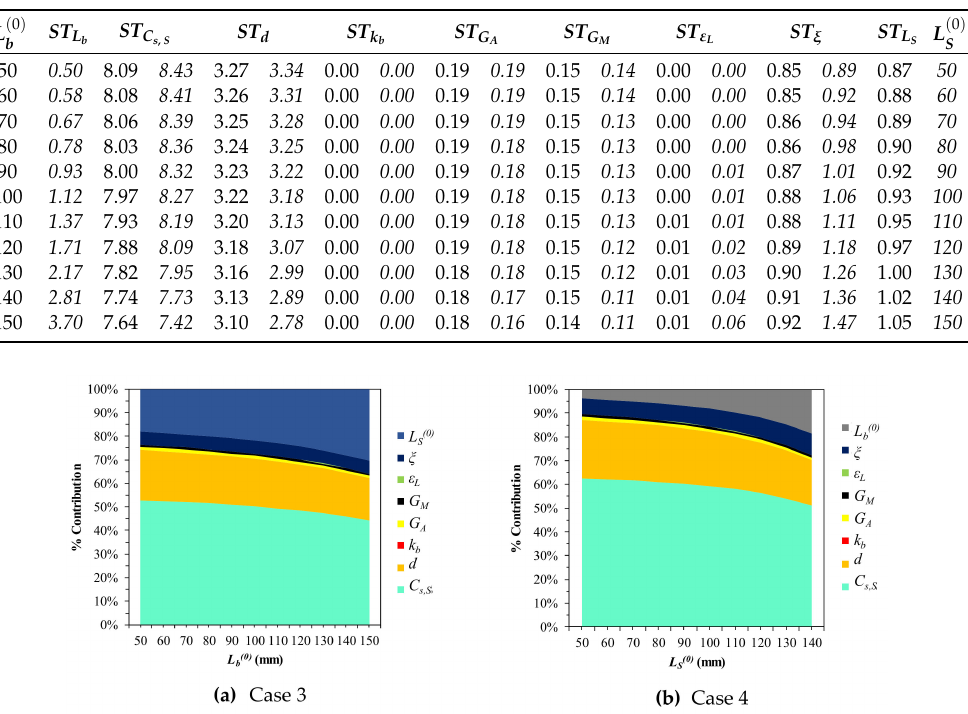
( 0 ) ( 0 ) ( 0 ) = 50; ( b ) L = 100; ( c ) L = 150. b b b